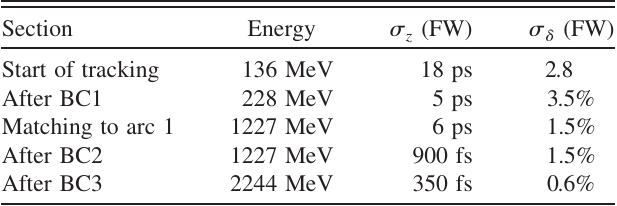
TABLE II. Bunch length and relative energy spread at critical